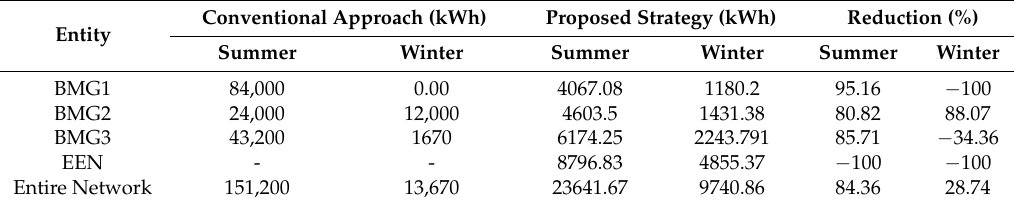
Table 3. Thermal energy loss in conventional approach and the proposed strategy in different seasons.